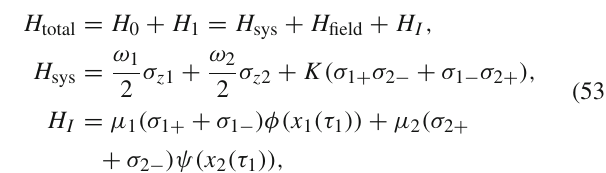
. d EPR vs. κ r when t = 100 μ . Other parameters are the same as 2 2